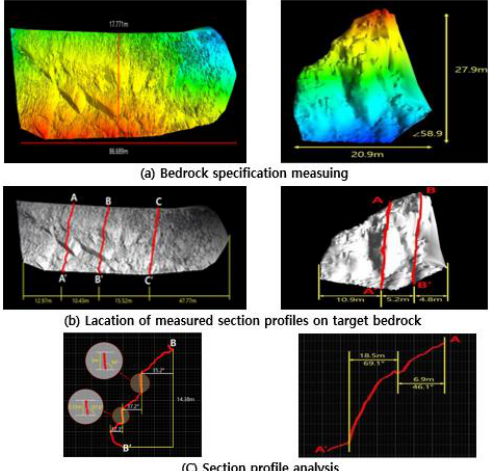
Figure 8. Section profile analysis